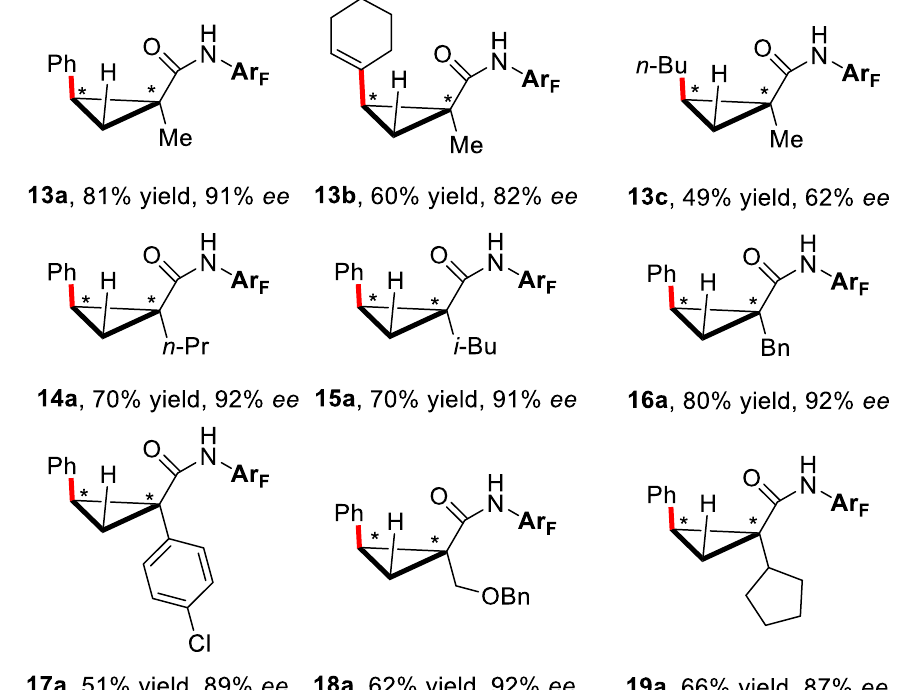
Figure 3. The substrate scope of asymmetric cyclopropane C – H functionalization [44].